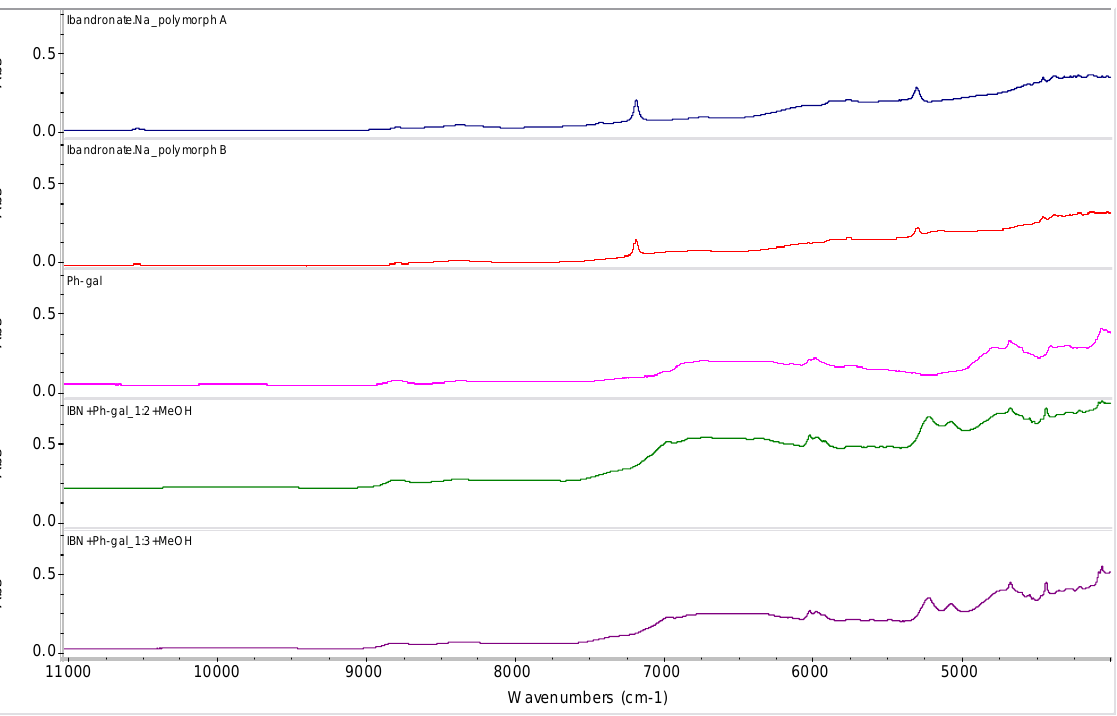
Figure 9. NIR spectra of ibandronate monosodium salt forms A and B, phenyl- β - D - galacto-pyranoside (Ph-gal) and spectra of potential co-crystals of IBN+Ph-gal in ratios 1:2 and 1:3 prepared by addition of MeOH and evaporation of liquid part at ambient temperature (samples 6 and 7